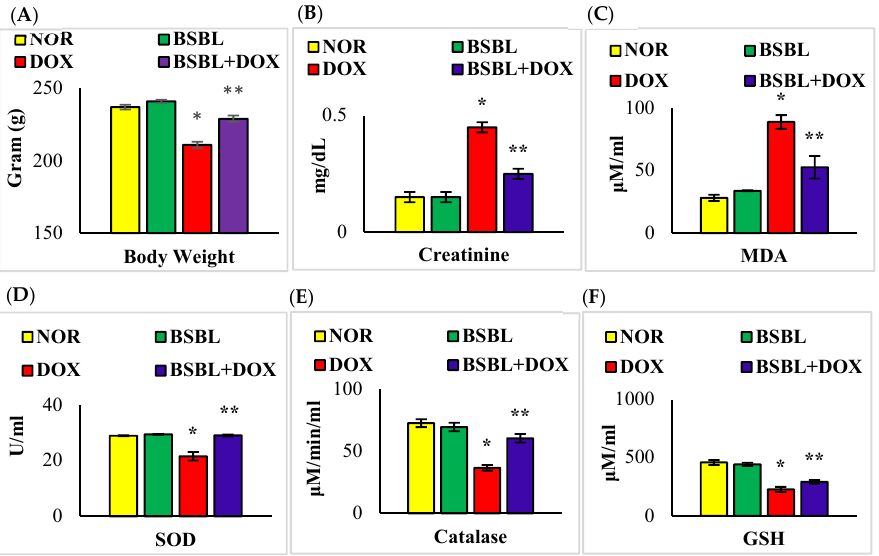
Figure 1. Effect of α -Bisabolol on body weight, renal injury, and oxidative stress markers in normal and DOX-injected rats. ( A , B ). Effect of α -Bisabolol on body weight and serum creatinine levels. DOX-injected rats showed a significant ( p < 0.05) decrease in body weight along with a significant ( p < 0.05) increase in the levels of creatinine in the serum compared to normal control rats, whereas α -Bisabolol treatment in DOX-treated rats significantly ( p < 0.05) decreased the body weight loss and serum creatinine levels compared to DOX-alone treated rats ( C – F ). Effect of α -Bisabolol on the levels/activities/concentrations of MDA, SOD, catalase, and GSH in the kidney of normal and DOX-injected rats. DOX-injected rats showed a considerable ( p < 0.05) decrease in the activities/levels of enzymatic and non-enzymatic antioxidants in the kidney compared to normal control rats, while α -Bisabolol treatment showed a significant ( p < 0.05) decrease in the activities/levels of enzymatic and non-enzymatic antioxidants in the kidney compared to DOX-alone treated rats. Each column is mean ± SEM for eight rats in each group; columns not sharing a common symbol (*, **) differ significantly with each other (* p < 0.05 vs. normal control, ** p < 0.05 vs. DOX